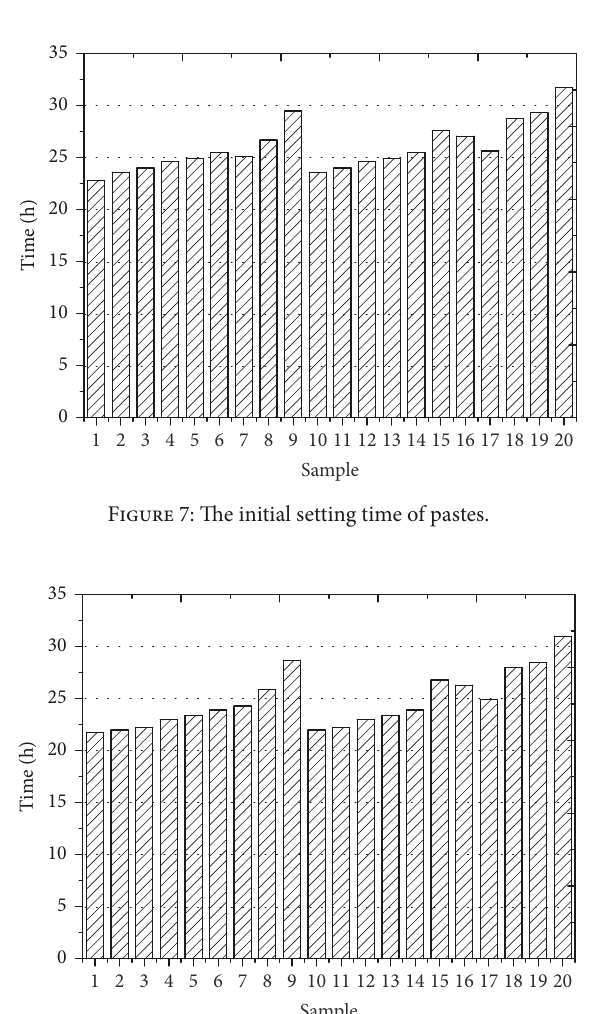
Figure 8: The final setting time of pastes.